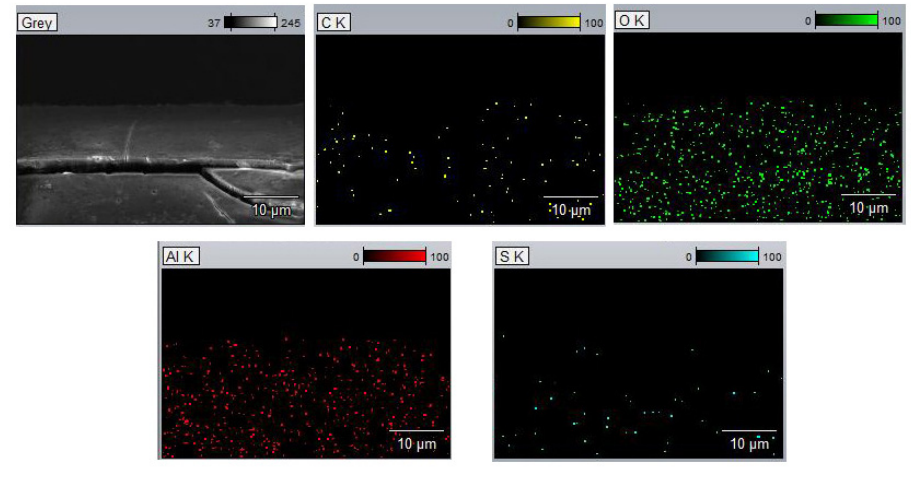
Figure 3. EDX map of anodic layer.